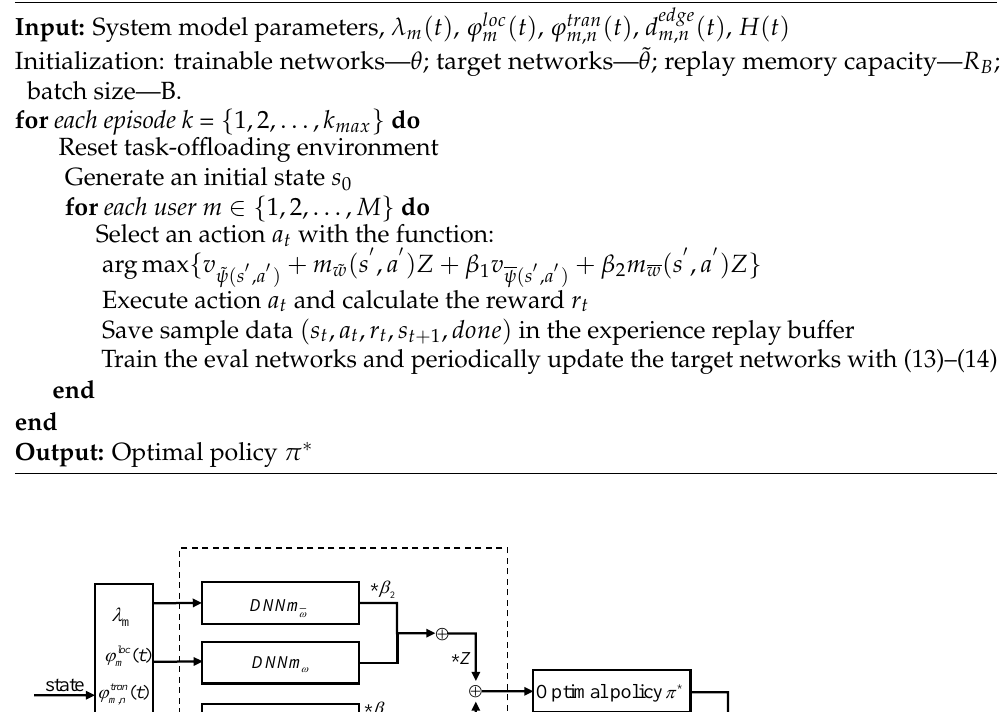
Algorithm 1 DRL-based solution for task-offloading decision in MEC system